Question: What visual encoding does this figure use to show its data?
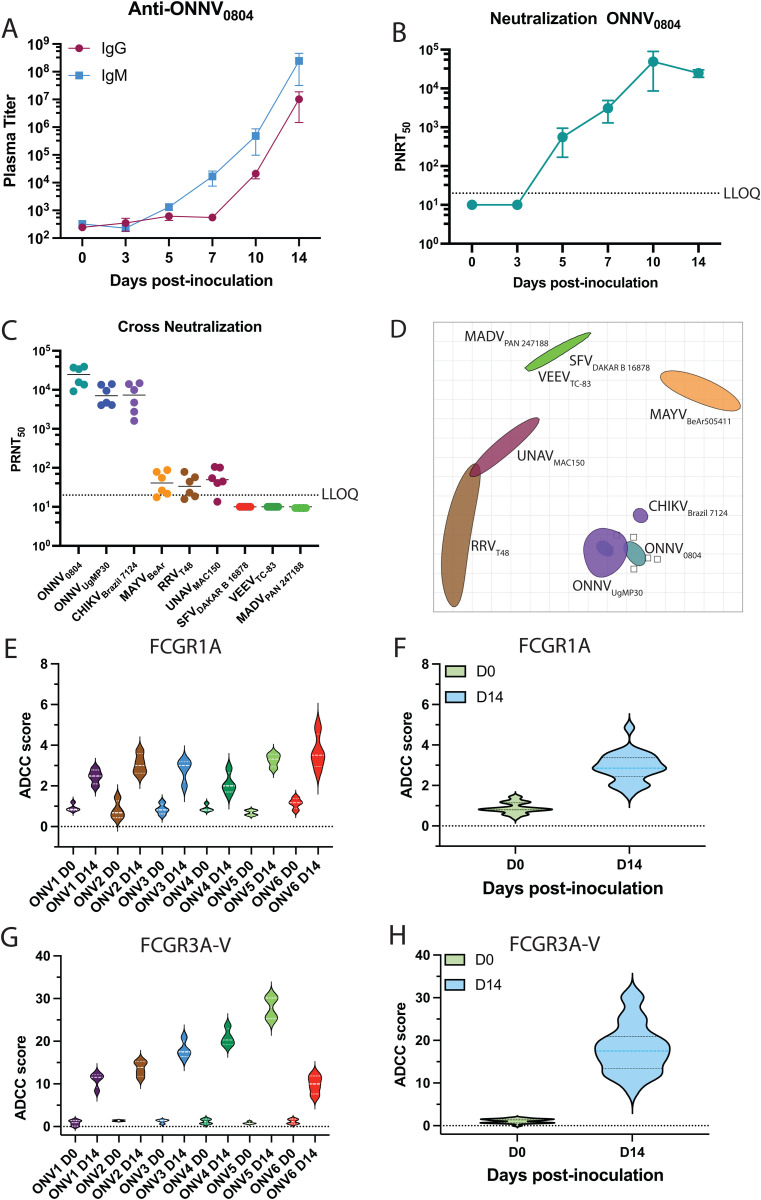
Answer: box